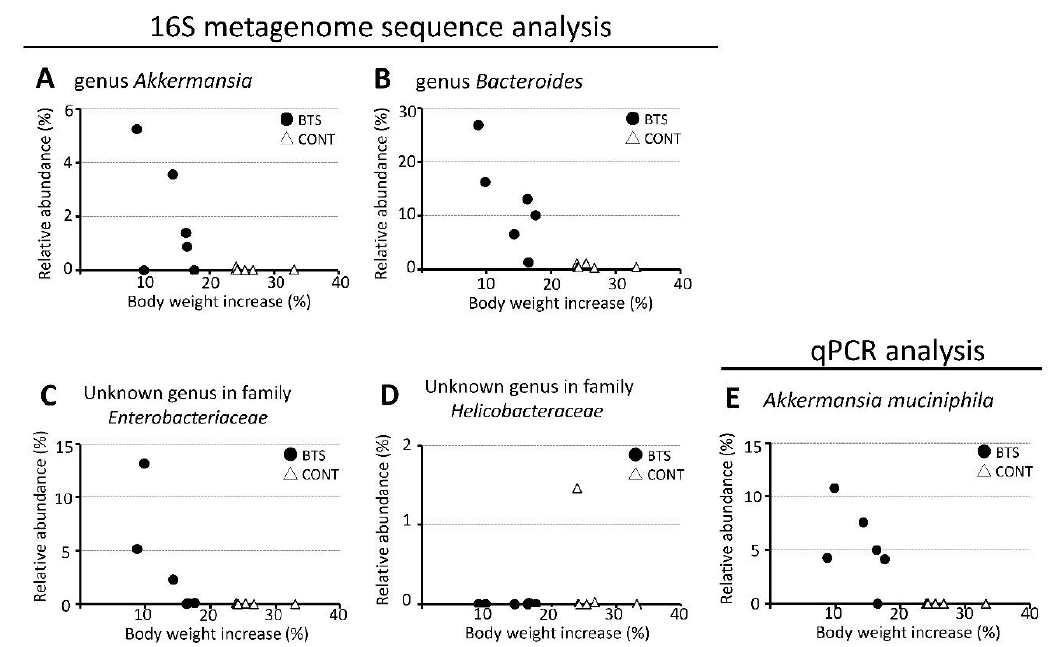
Figure 6. Scattered plot of relative abundance of stool bacteria versus relative increase of body weight. Genera Akkermansia ( A ) , Bacteroides ( B ), unknown genus in the family Enterobacteriaceae ( C ), and unknown genus in the family Helicobacteraceae ( D ), were analyzed by 16S metagenome sequencing and plotted versus relative increase of body weight. Only Akkermansia muciniphila was analyzed by qPCR ( E ). Open triangle, CONT group; closed circle, BTS group. Increase of body weight (%) was calculated as follows: 100 × ((body weight at Week 4) − (body weight at Week 0))/(body weight at Week 0).